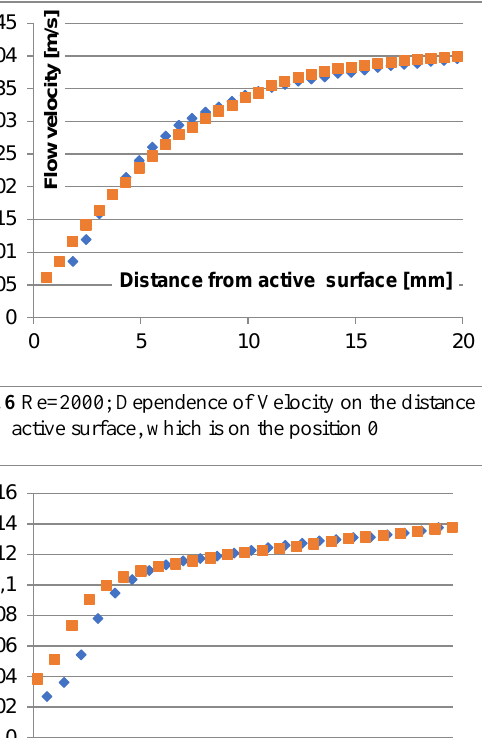
Fig.4 The visualization of the air film with the microscope magnification 10x. [3]